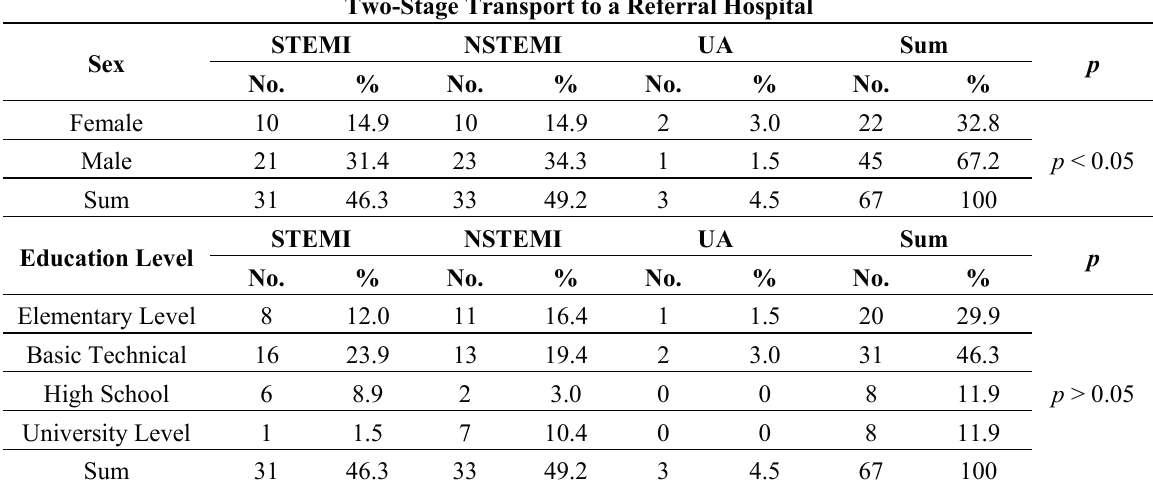
Table 1. Patients’ Demographic Data. Sex: In the STEMI and NSTEMI groups the majority of patients were men. In the UA group the majority of patients were women. The gender difference between the groups is statistically significant. Education: Analysis of patients according to the education level, showed that in all the groups patients with elementary level and basic technical education prevailed. The difference in education level between the groups of patients was not statistically